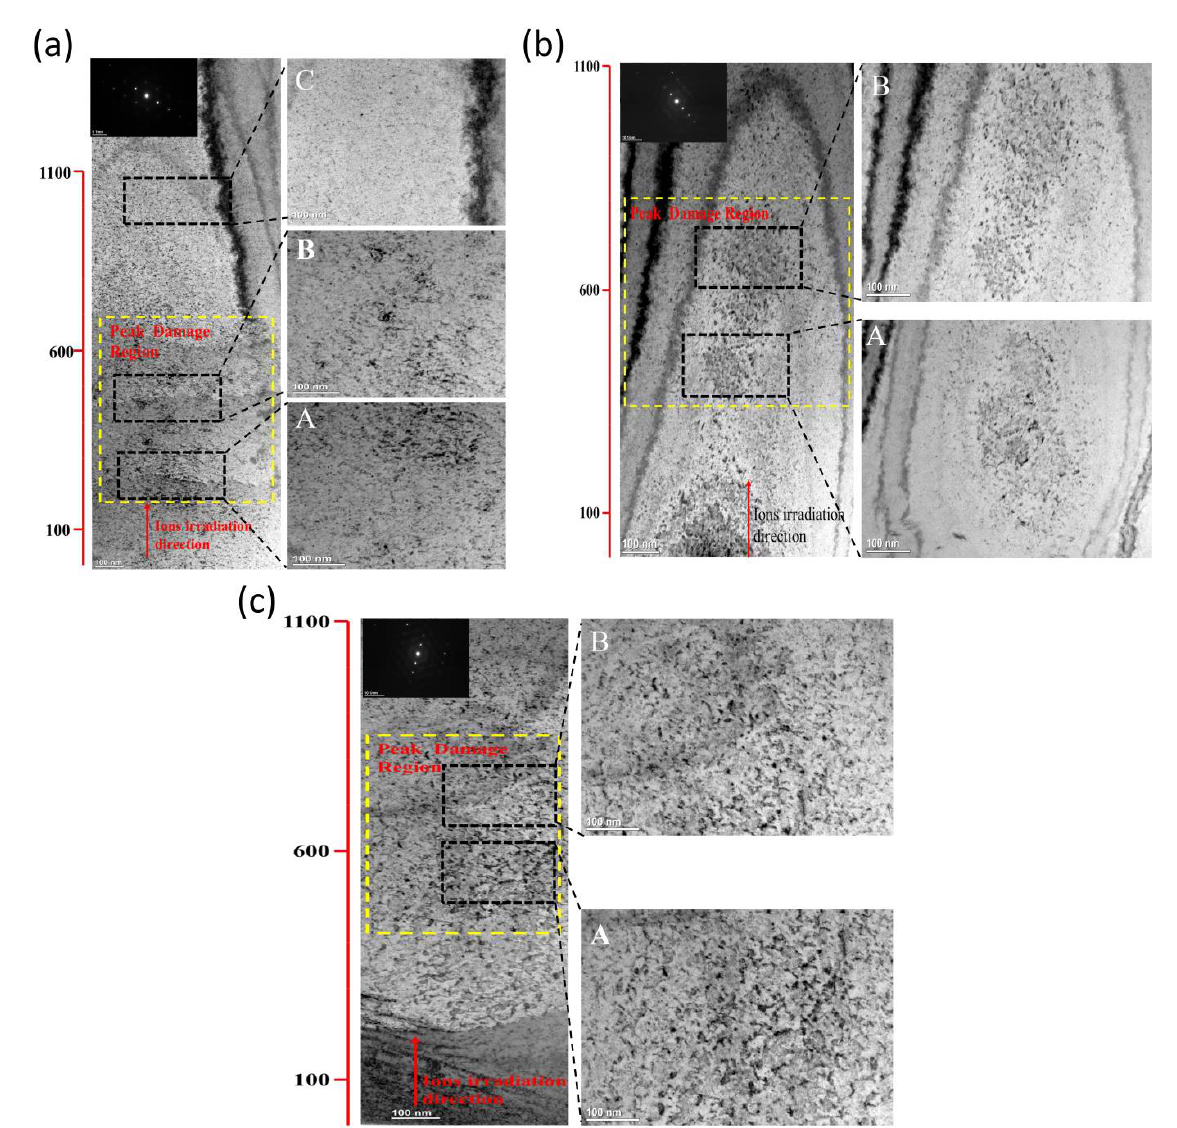
Figure 8. BF-TEM images of irradiated samples showing the irradiation-induced black-dot defects ( a ) 500 °C—8 × 10 15 sample of Zr 40 Nb 35 Ti 25 , ( b ) 500 °C—8 × 10 15 sample of Zr 50 Nb 35 Ti 15 , and ( c ) 500 °C—2.5 × 10 16 sample of Zr 60 Nb 35 Ti 5 . The g = <110> near the [111] zone axis was selected. A, B, and C are the local enlargements of each sample along the irradiation direction.